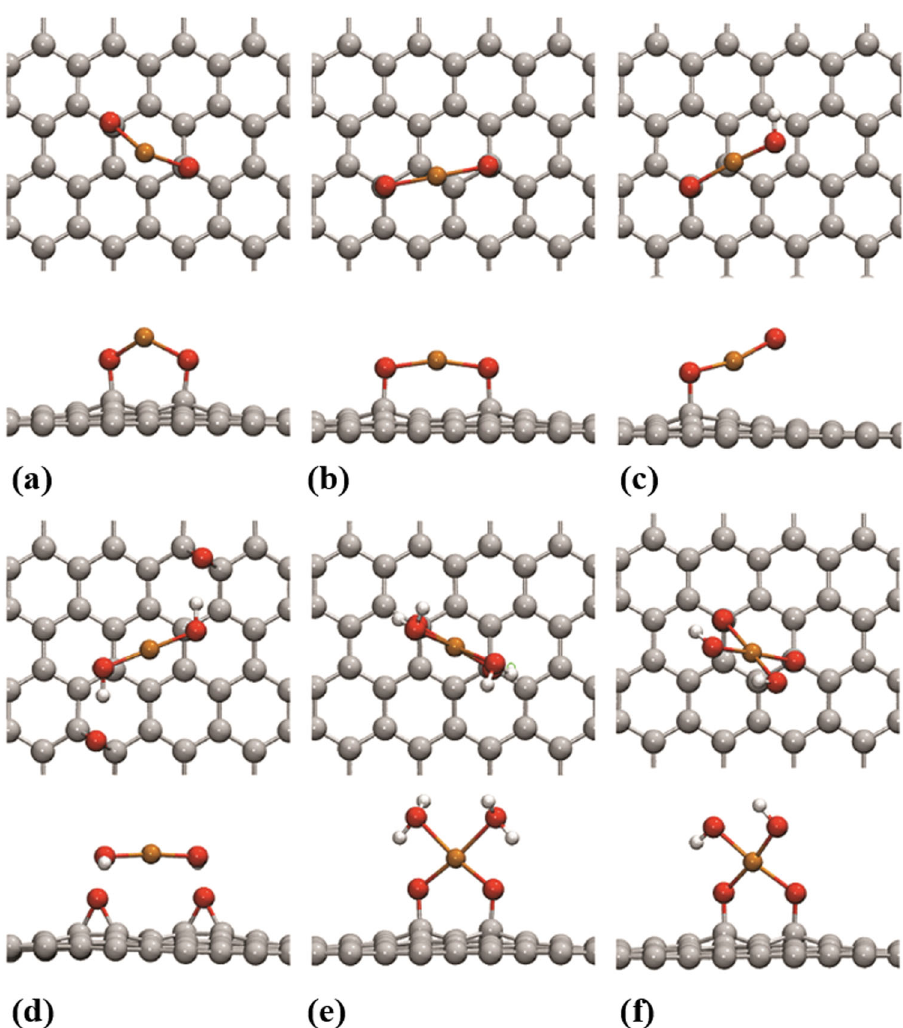
Fig. 3 Ball and stick representation of Cu-N-rGO structures. a , b Cu ion is coordinated to two surface – O − groups, c Cu ion is coordinated to one surface – O − group and also bound to one hydroxyl group, d Cu ion is coordinated to two surface epoxide groups, e , f Cu ion is coordinated to two surface – O − groups and also bound to hydroxyl groups. Gray spheres represent C atoms, red spheres O atoms, white spheres H atoms and orange spheres Cu